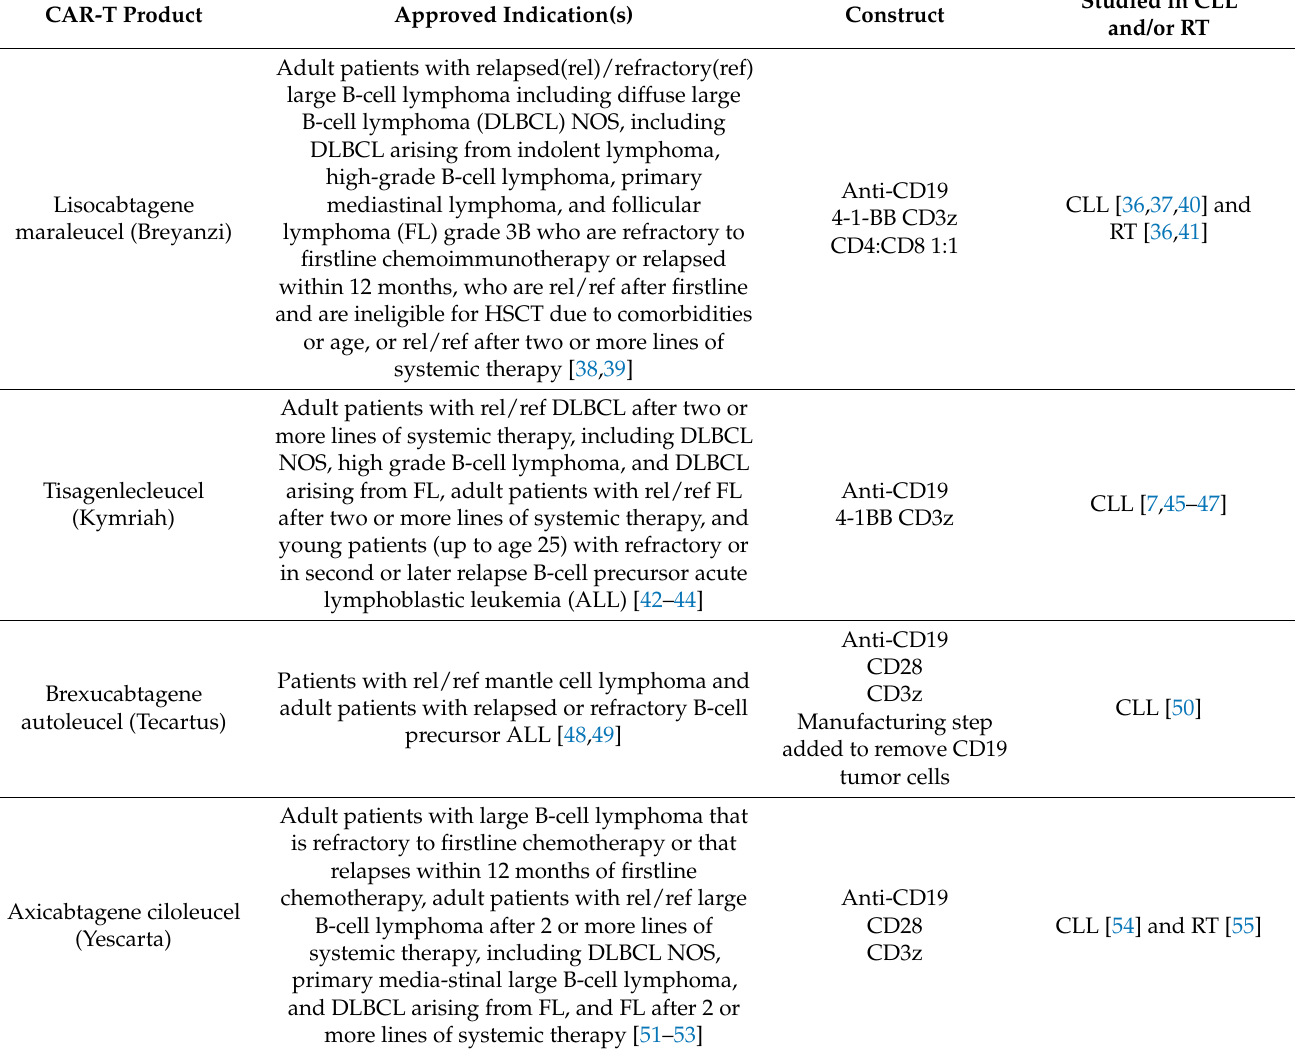
Table 1. FDA-approved CD19 targeted CAR-T products, approved indications, characteristics, and whether products have been studied in CLL and/or